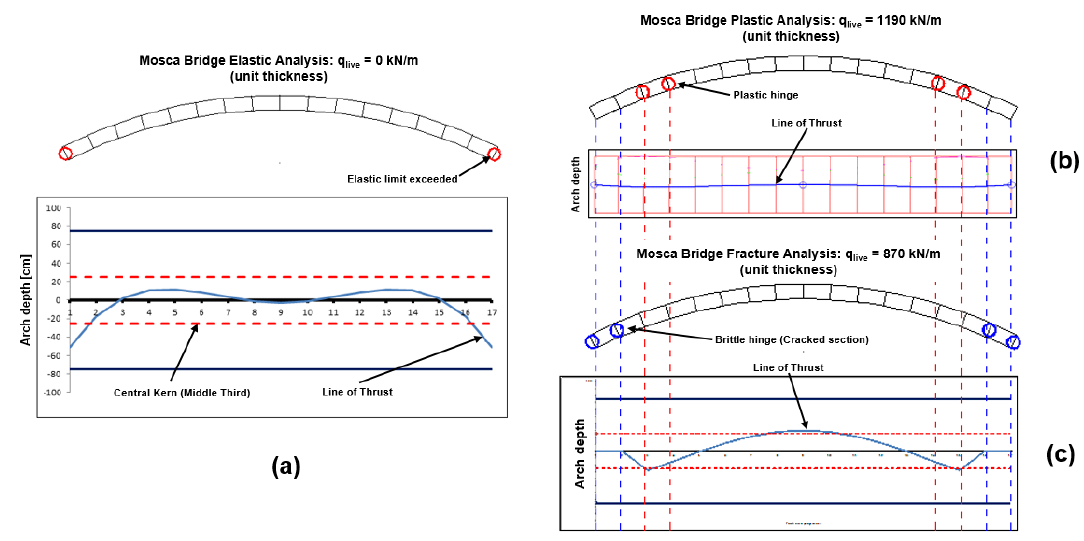
Figure 8. Mosca bridge: ( a ) Elastic, ( b ) plastic, and ( c ) fracture analyses.